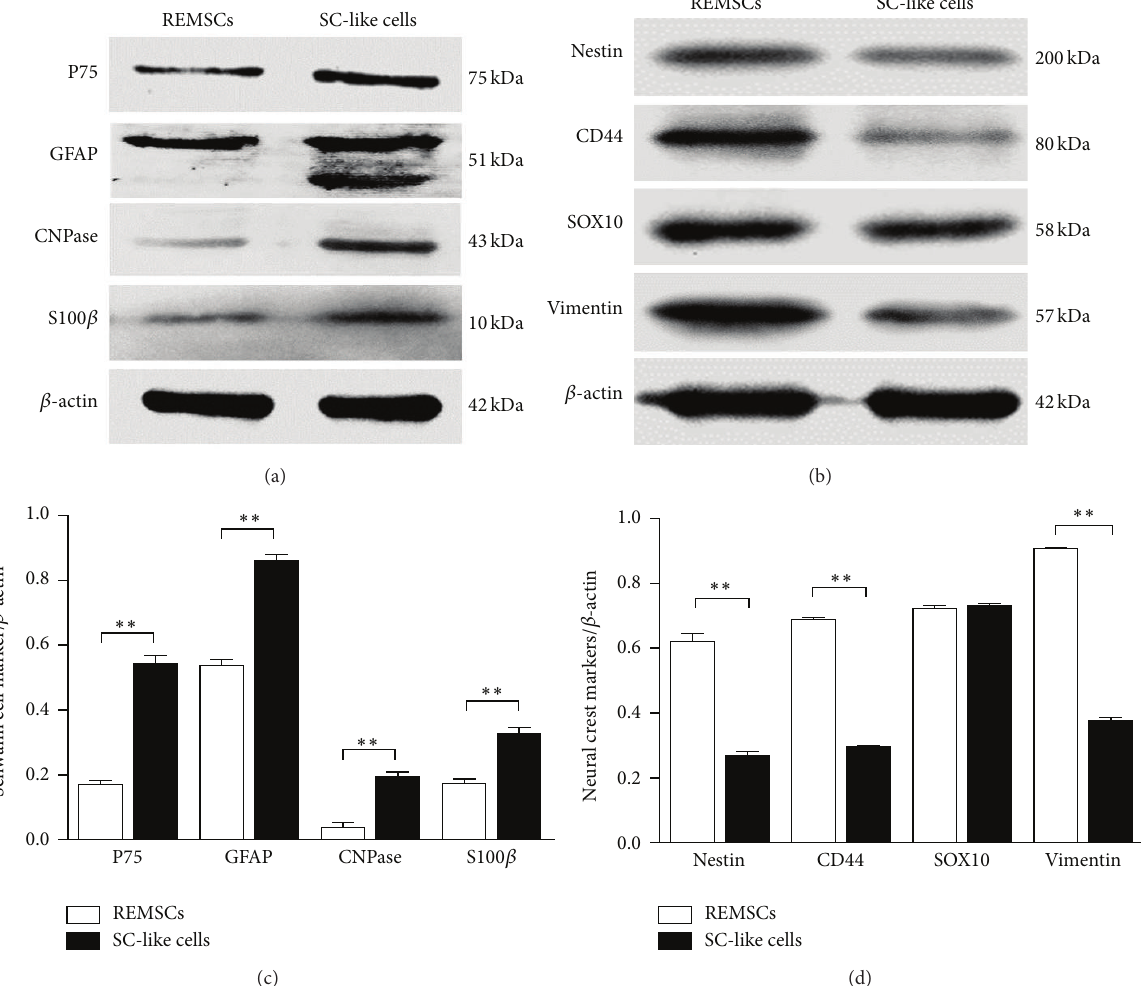
Figure 4: Western blotting showed the upregulation of expression of Schwann cell markers and the downregulation of expression of neural crest markers except for SOX10. Expressions of Schwann cell markers including GFAP, CNPase, P75, and S100 𝛽 by REMSCs and SC-like cells wereshownin(a);expressionsofneuralcrestmarkersincludingSOX10,nestin,vimentin,andCD44byREMSCsandSC-likecellswereshown in (b); the experiments were replicated three times, and 𝛽 -actin was used as a loading control. Quantitation of each marker was calculated using morphometric analysis with ImageJ software. Each bar showed the ratio of the expression level of marker protein to 𝛽 -actin (c, d). The data were presented as mean ± SEM of three independent experiments. ∗∗ 𝑃 < 0.01 represented significant differences when compared between RMSCs and SC-like